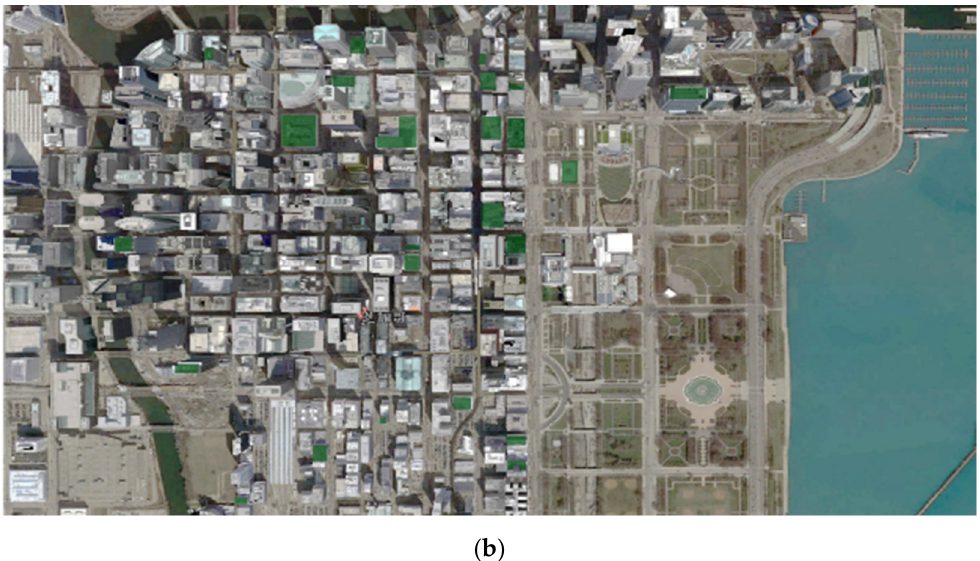
Figure 3. Data Validation. ( a ) Chicago Green Roof Spatial Dataset (2012); ( b ) Chicago Satellite Map